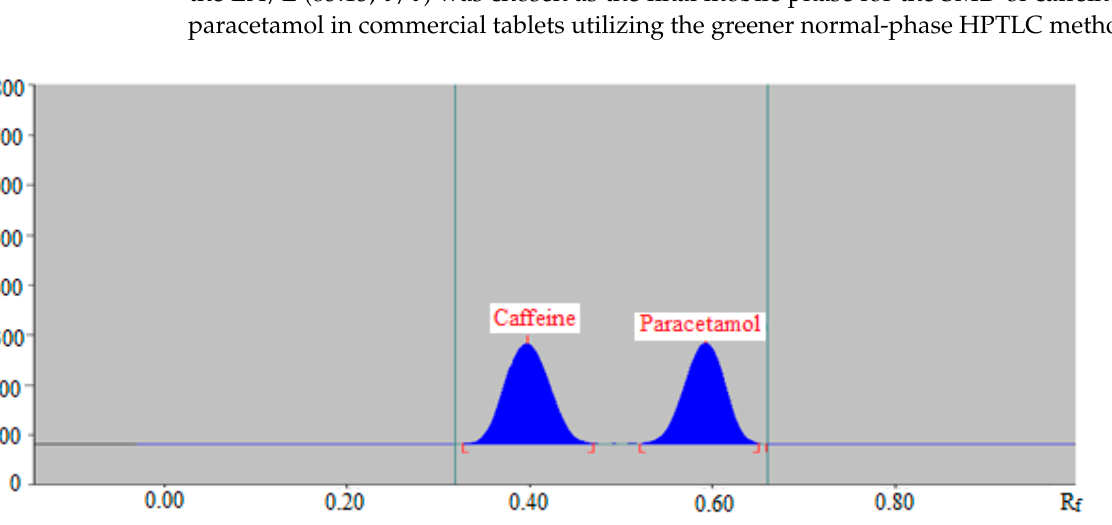
Figure 2. Normal-phase high-performance thin-layer chromatography (HPTLC) chromatogram of Figure 2. Normal ‐ phase high ‐ performance thin ‐ layer chromatography (HPTLC) chromatogram of standard caffeine and standard caffeine and paracetamol.